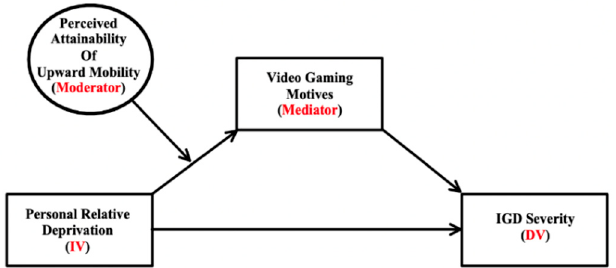
Figure 1. This conceptual diagram displays personal relative deprivation predicting IGD severity via gaming motives (i.e., coping, financial, mood enhancement, and social) at different levels of perceived upward mobility. IV = Independent variable; DV = Dependent variable; IGD = Internet gaming disorder.